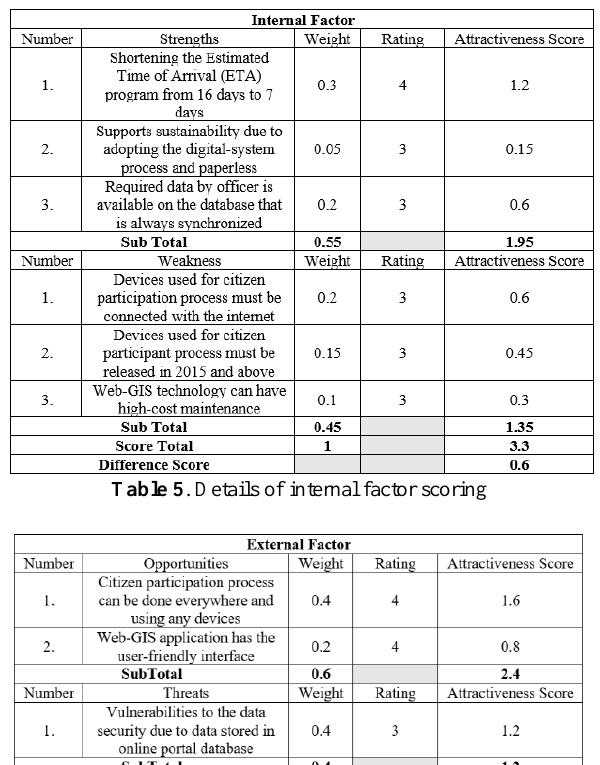
Table 3 . Detail of Estimated Time of Arrival comparison